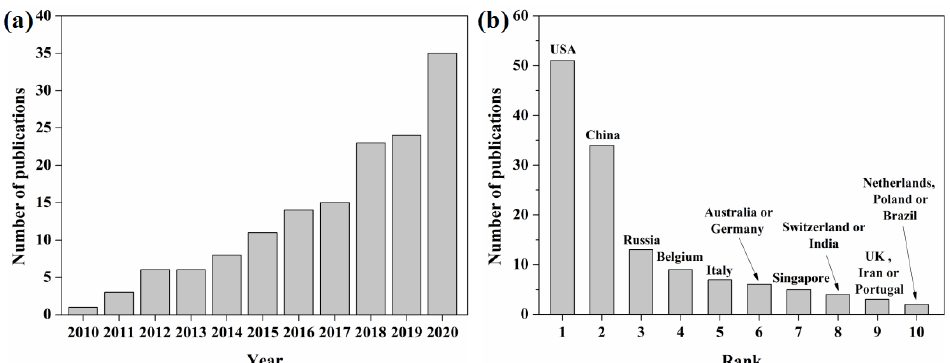
Figure 2. Published papers on additive manufactured Ni-Ti alloys by Web of Science: ( a ) number of papers published in different years; ( b ) number of papers published by different countries/regions.